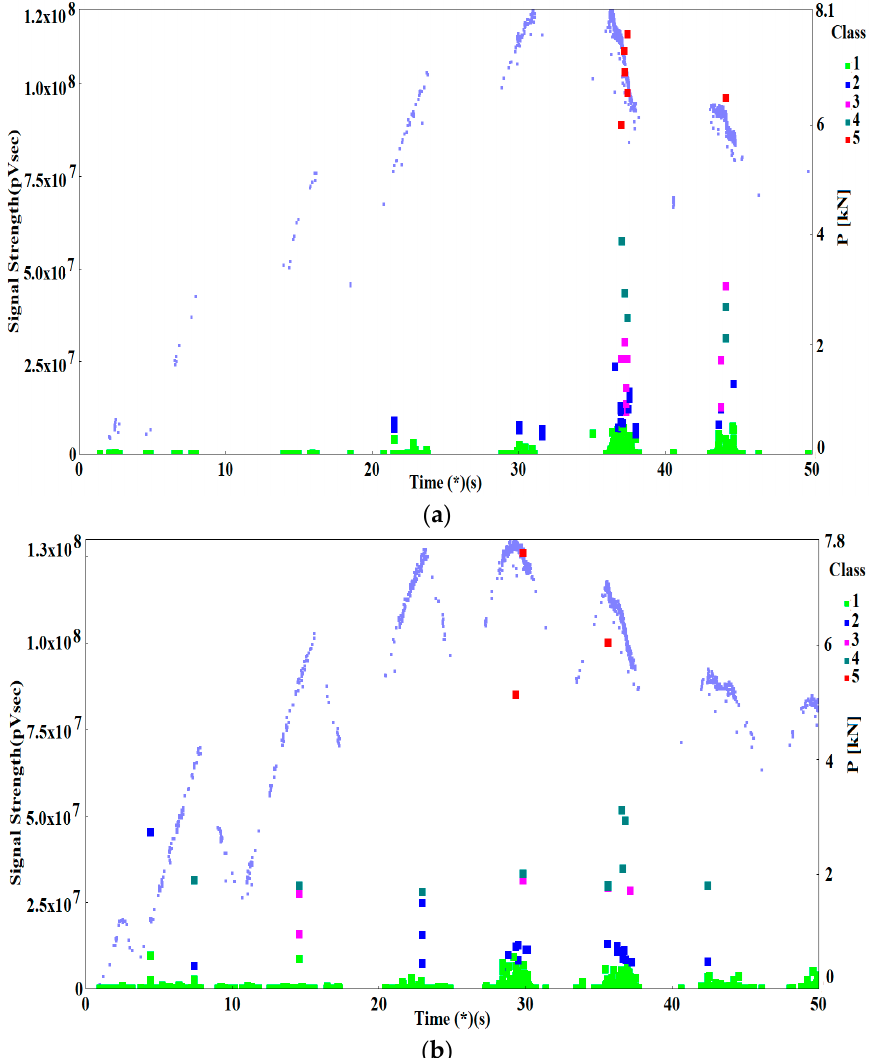
Figure 8. Point charts of signal strength (SS) over time with breakdown into classes describing the characteristic fracture mechanisms. ( a ) for T 1 = 20 °C; ( b ) for T 2 = − 50